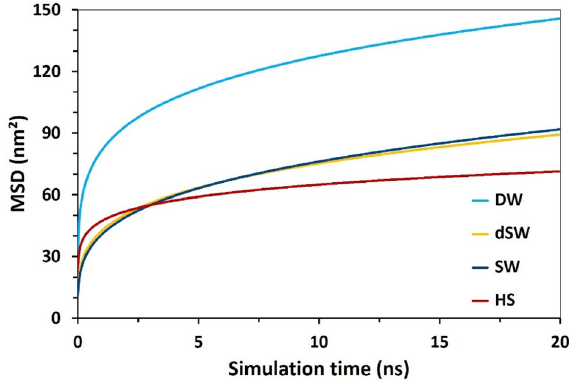
Figure 11. The mean square displacement of BA at different salinities.